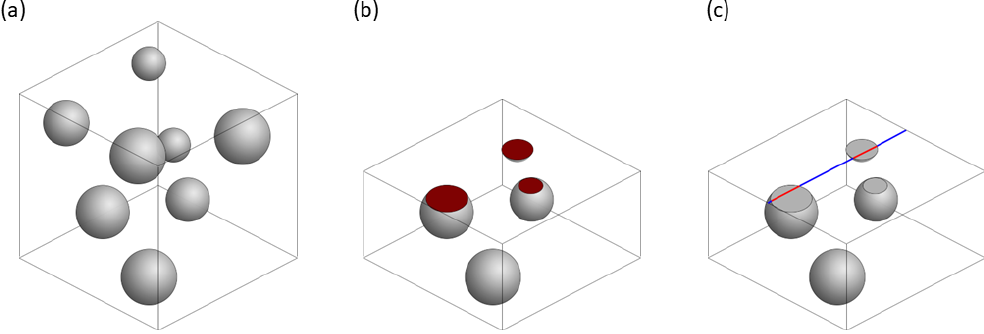
Figure 1. ( a ) A 3D particle dispersion. ( b ) A cross-section through the dispersion, cutting through particles. ( c ) A line intercept passing through